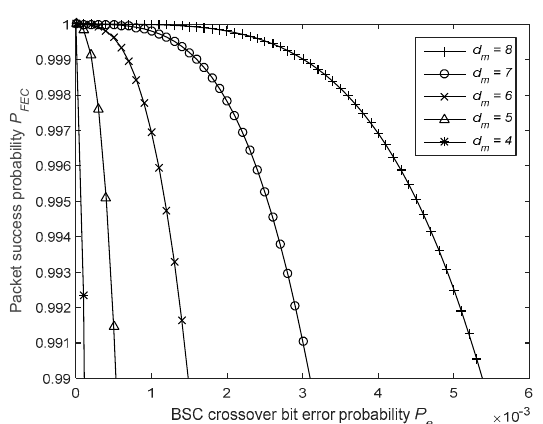
Figure 16. Impact of the free distance d m on the packet success probability.